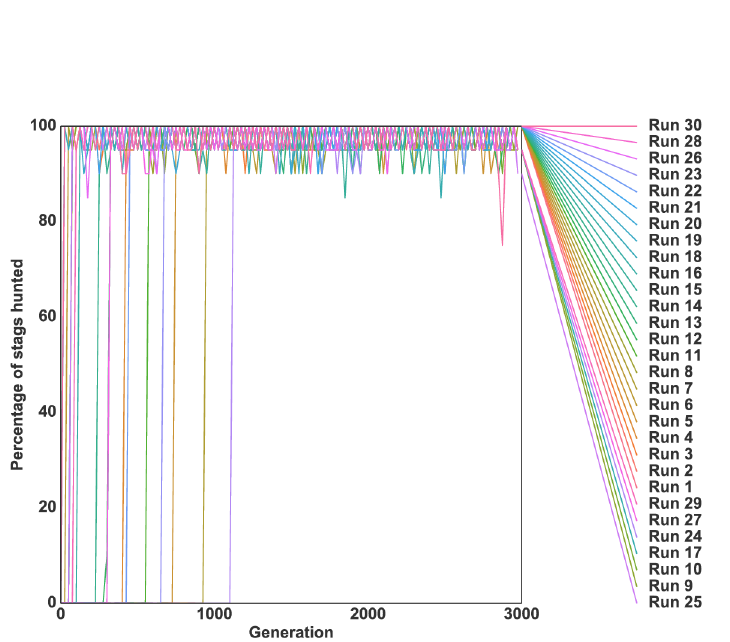
Fig 4. Evolution of cooperation in a game-theoretic simulation with an initial hare-hunting strategy. Evolution of the mean percentage of stags hunted successfully (i.e. cooperatively) with respect to the total number of prey hunted when starting with a population of hare hunters for 30 independent runs. Rewards were 50 for a hare, 0 for a stag hunted alone, and 500 for a stag hunted cooperatively as presented